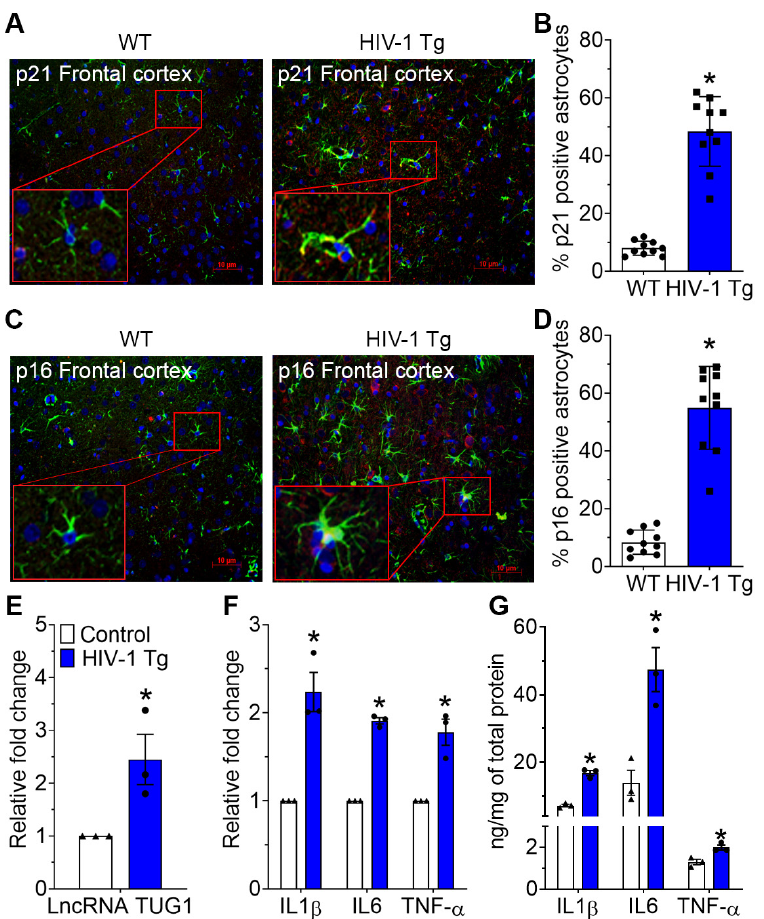
Figure 4. HIV-1 Tg rats showed increased astrocytic senescence-associated markers. Representative immunofluorescence images showing the colocalization of p21 ( A , B ) and p16 ( C , D ) with GFAP in the prefrontal cortices of wild-type and HIV-1 Tg rats. Scale bar: 10 μ m. qPCR showing the expression of